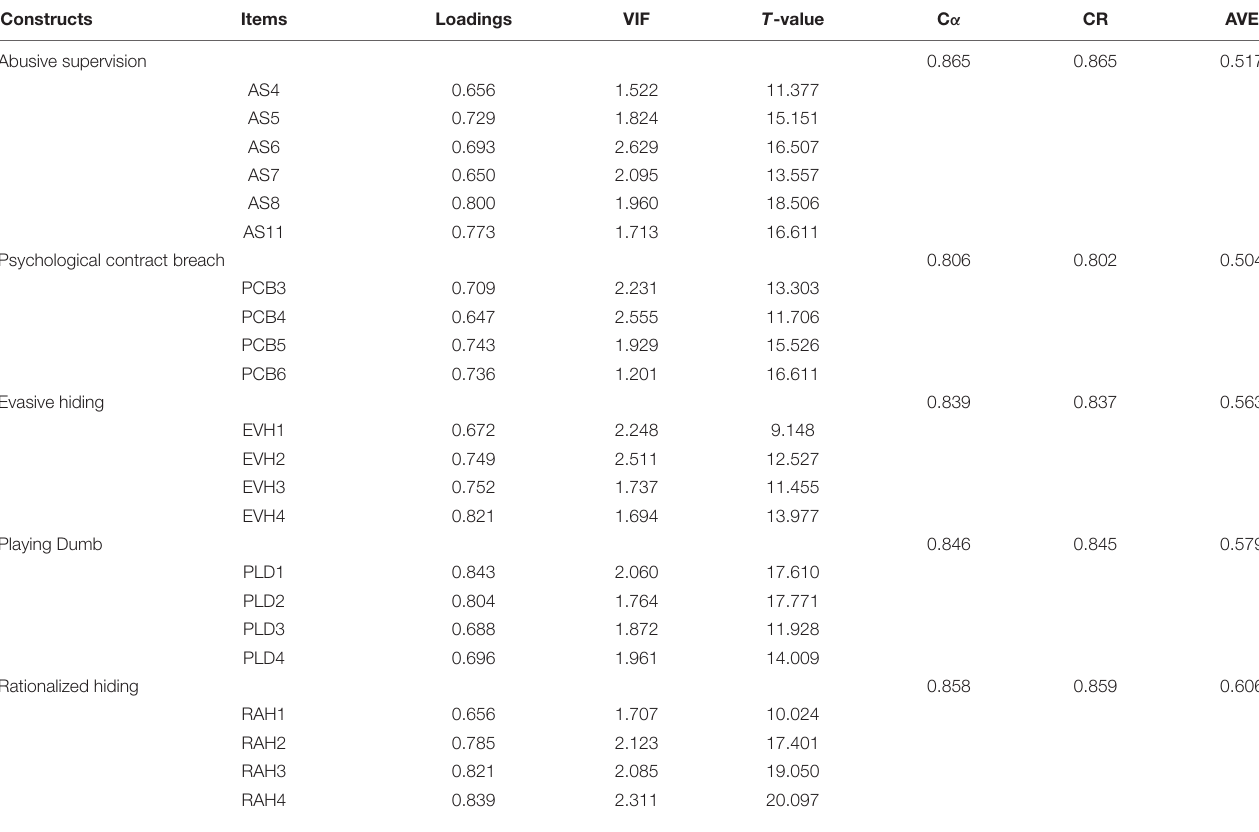
TABLE 1 | Reliability and validity measures.